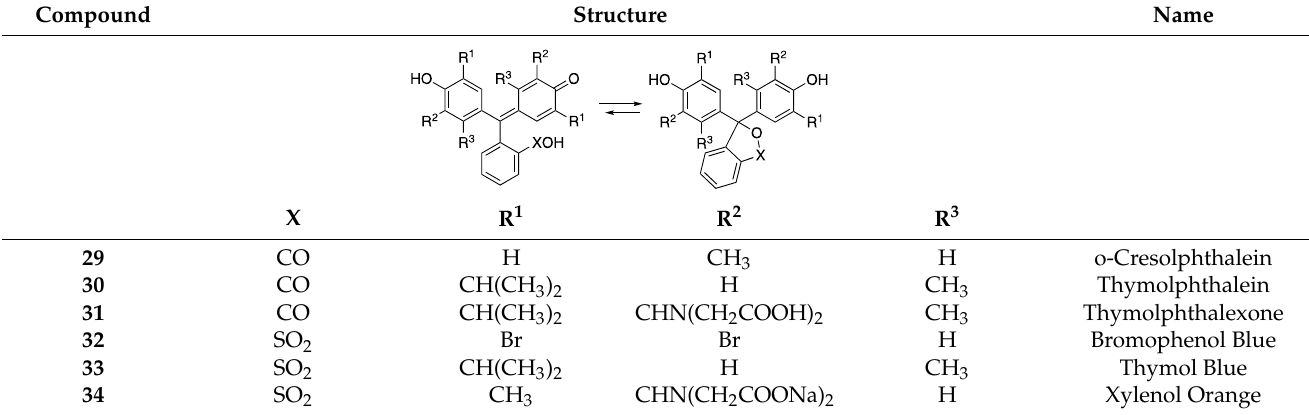
Table 4. Arylmethane phthalein indicators.